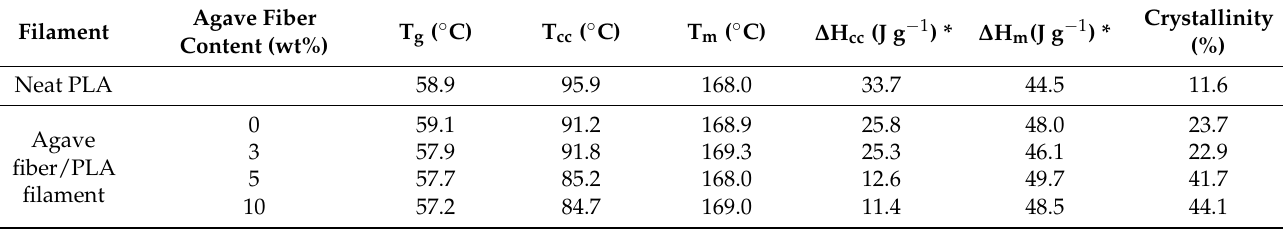
Table 1. Thermal properties and crystallinity values of the filaments.